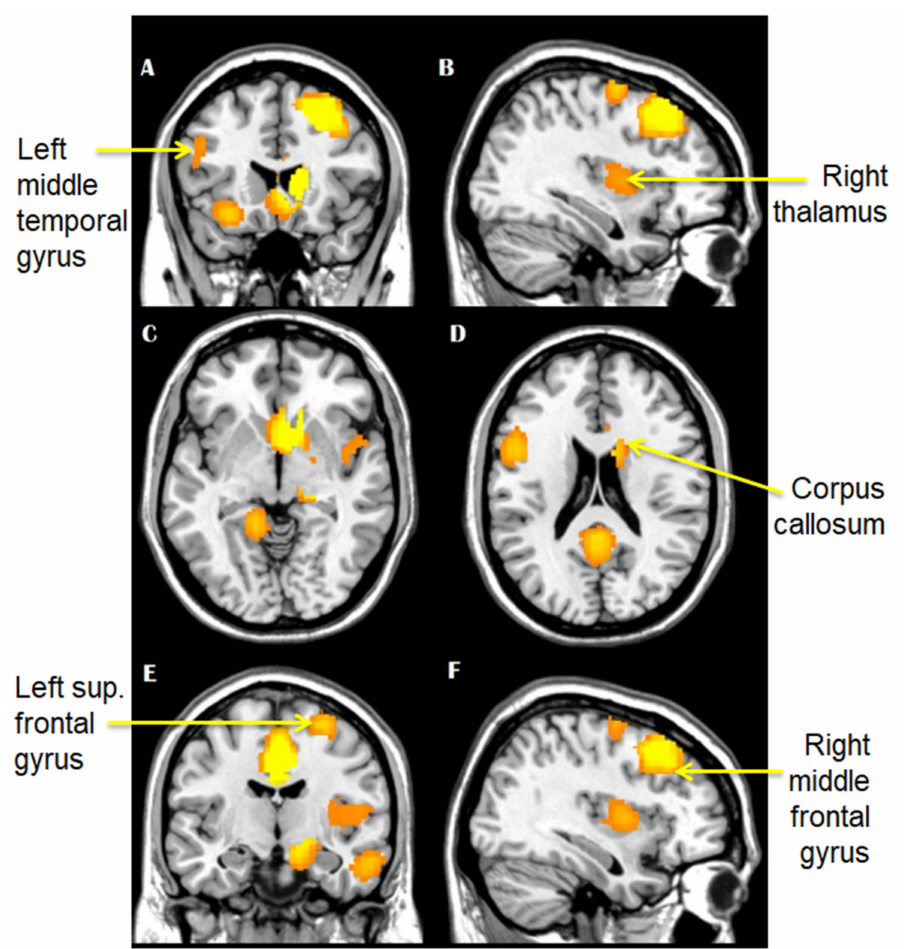
Figure 4. ( A – F ): Brain areas that showed decreased grey matter volume in mTBI patients, as compared to